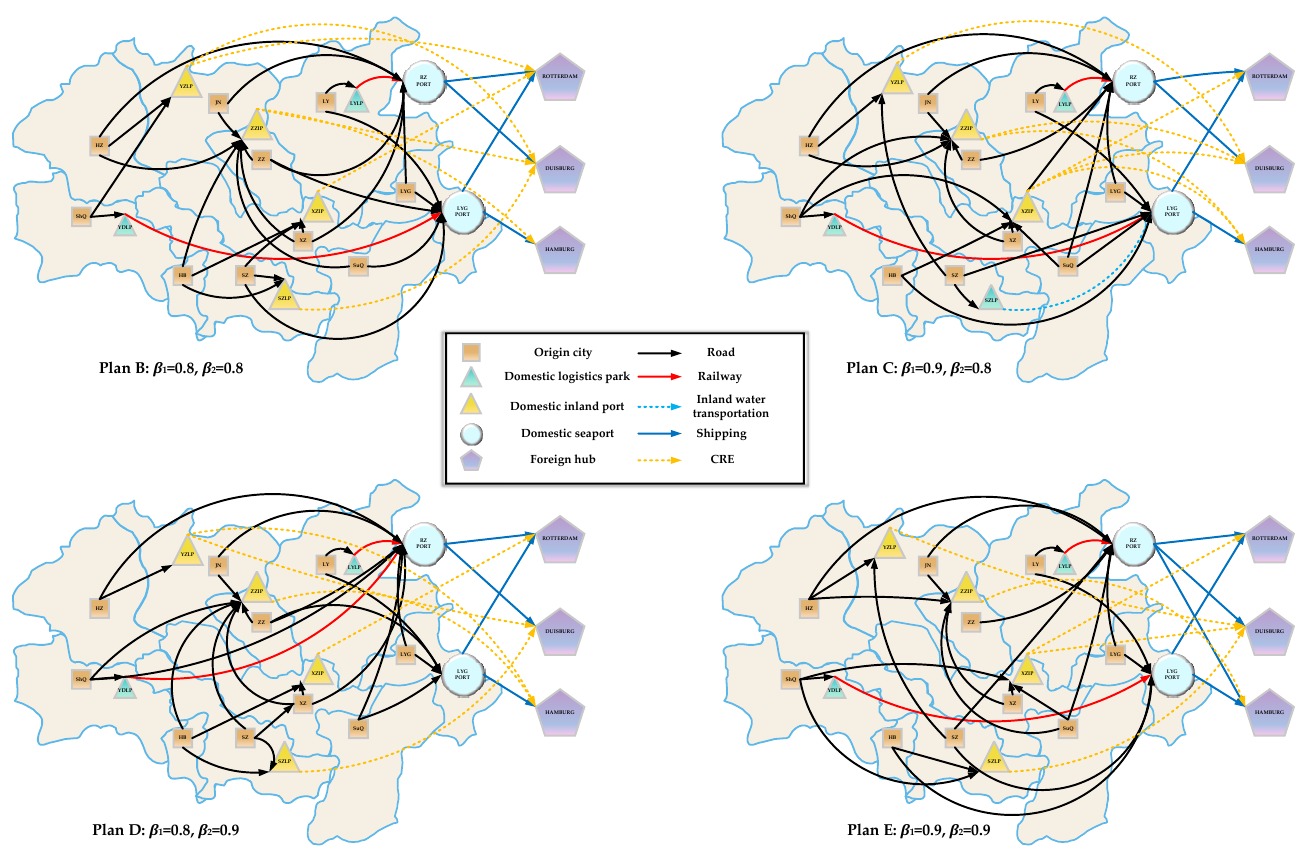
Figure 13. Optimal network plans on different scenarios.